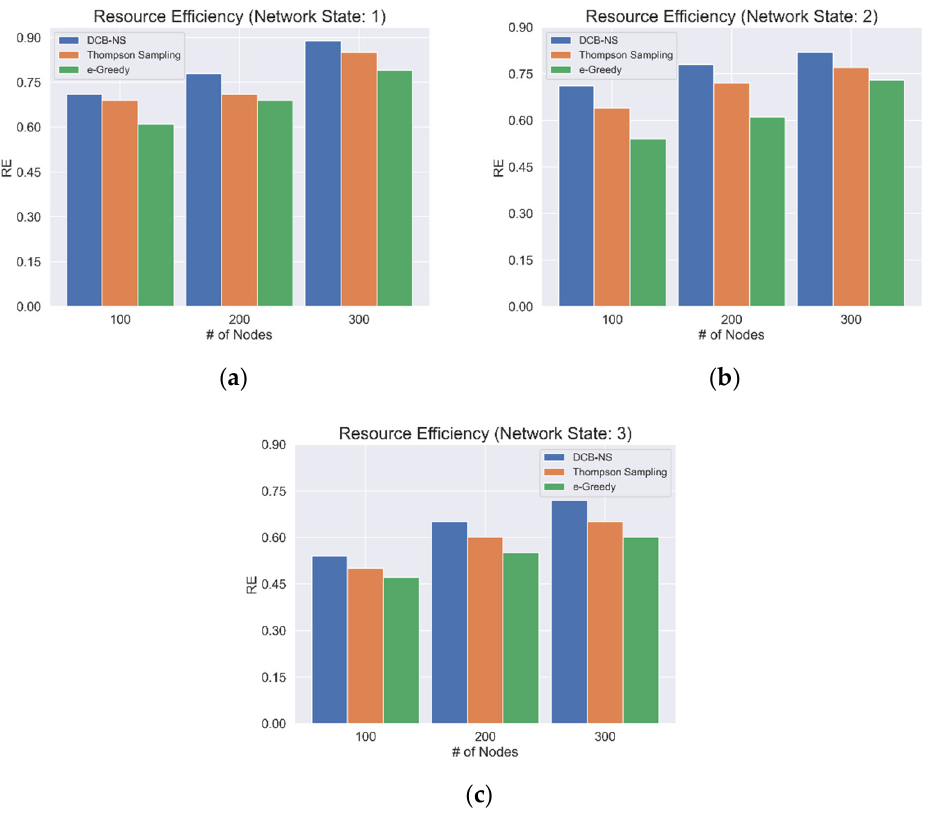
Figure 5. Average Network Resource Efficiency for ( a ) Network State 1, ( b ) Network State 2, and ( c ) Network State 3.